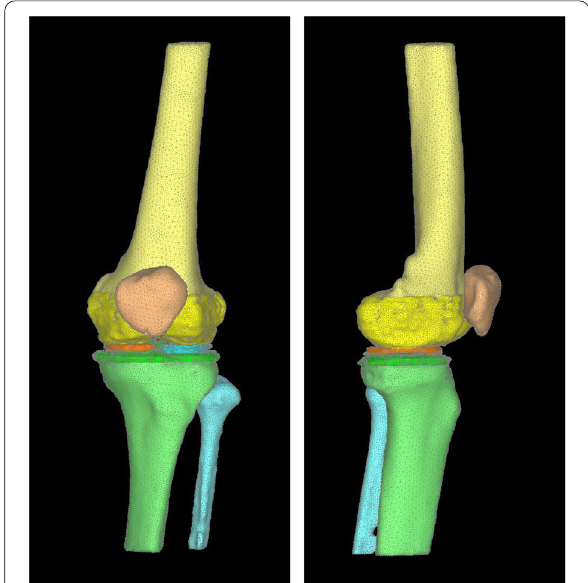
Fig. 1 Finite element model. Finite element model from femur to tibia and fibula, which was based on a 65-year-old woman. The KL classification was grade 1, the FTA was 177.6°, the MPTA was 86.3°, the LDFA was 83°, and the JLCA was 1.1° in the full leg weight-bearing radiographs. MRI showed no posterior root tear of the medial meniscus, and the MME was 1.2 mm at the middle of the anteroposterior diameter of the tibia. KL; Kellgren-Lawrence, FTA: femolo-tibial angle, MPTA; medial proximal tibial angle, LDFA; lateral distal femur angle, JLCA; joint line convergence angle, MME; medial meniscus